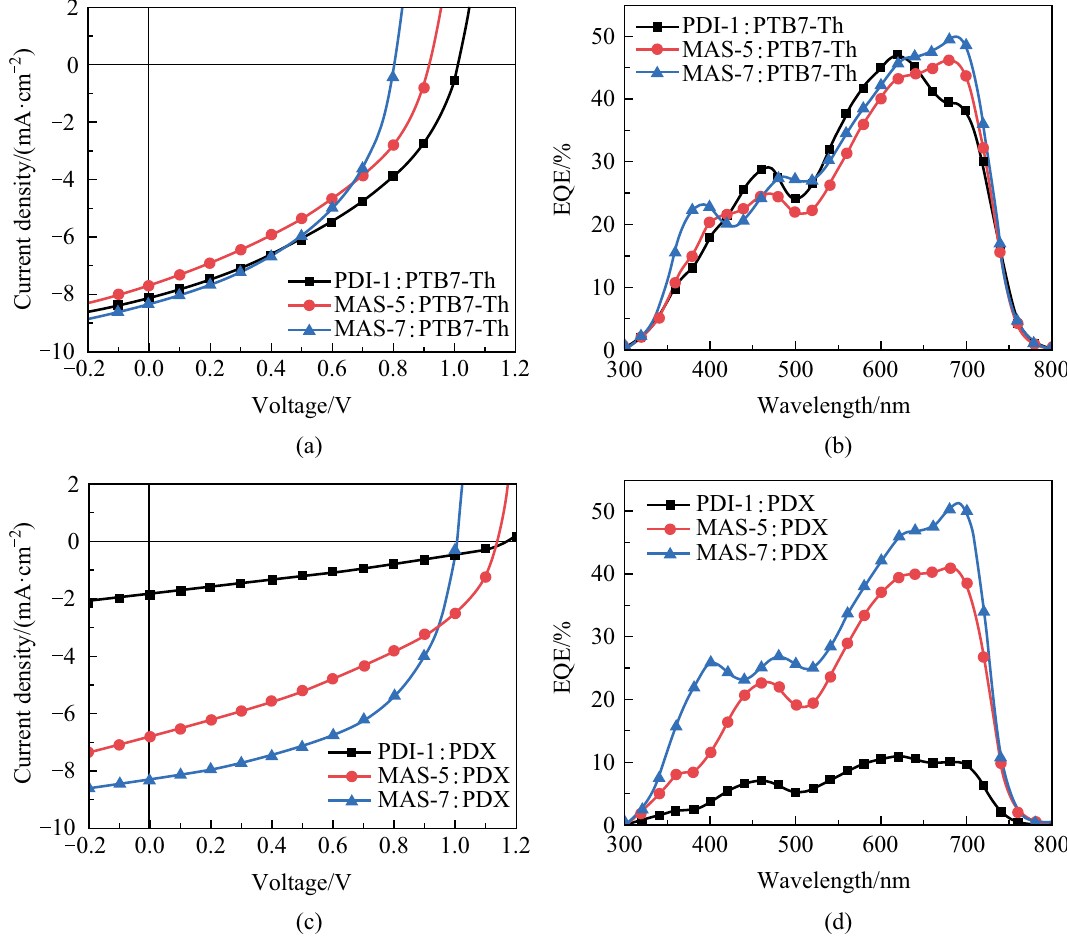
Fig. 4 a J–V curves and b EQE spectra of the OSCs based on PTB7-Th:Acceptor; c J–V curves and d EQE spectra of the OSCs based on